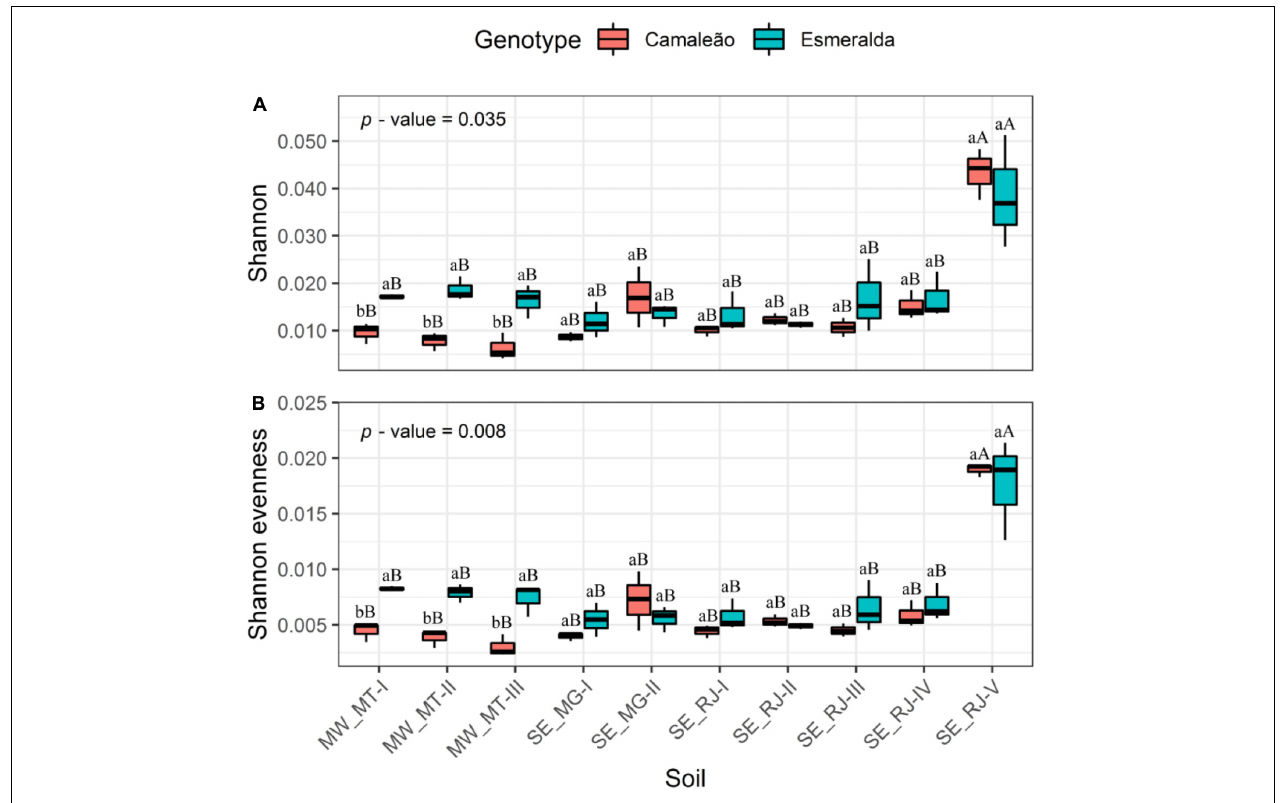
FIGURE 4 | (A) Shannon’s diversity and (B) evenness of bacterial communities from nodules of Camaleão and Esmeralda mung bean genotypes inoculated with 10 different soils. p -values are based on anava. Distinctive letters, lowercase between genotypes and uppercase between soils, indicate statistical difference by the Scott–Knott test at 5%